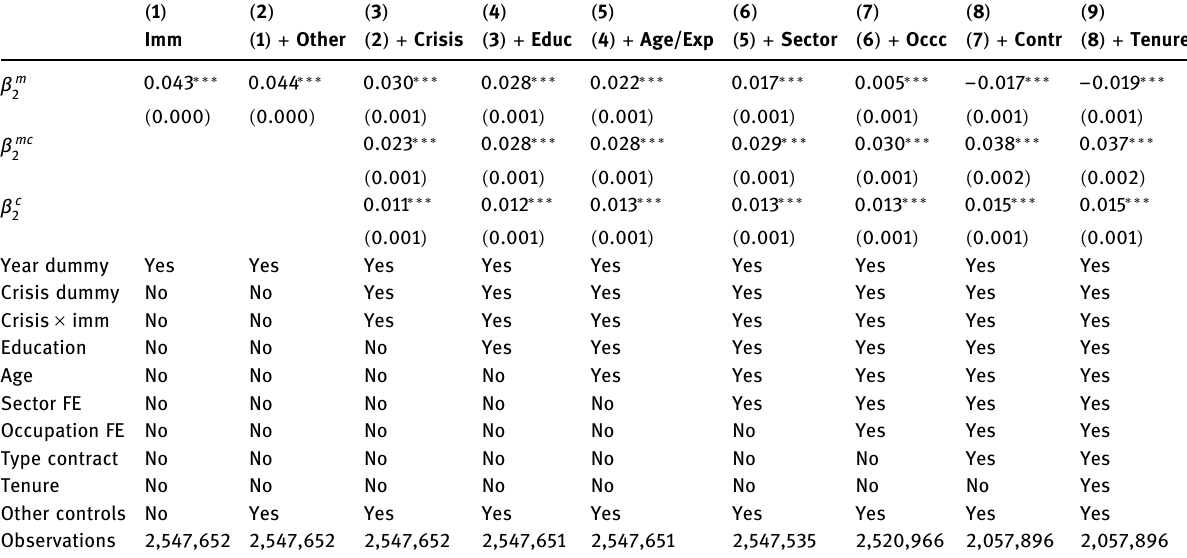
Table 4: Estimation results: